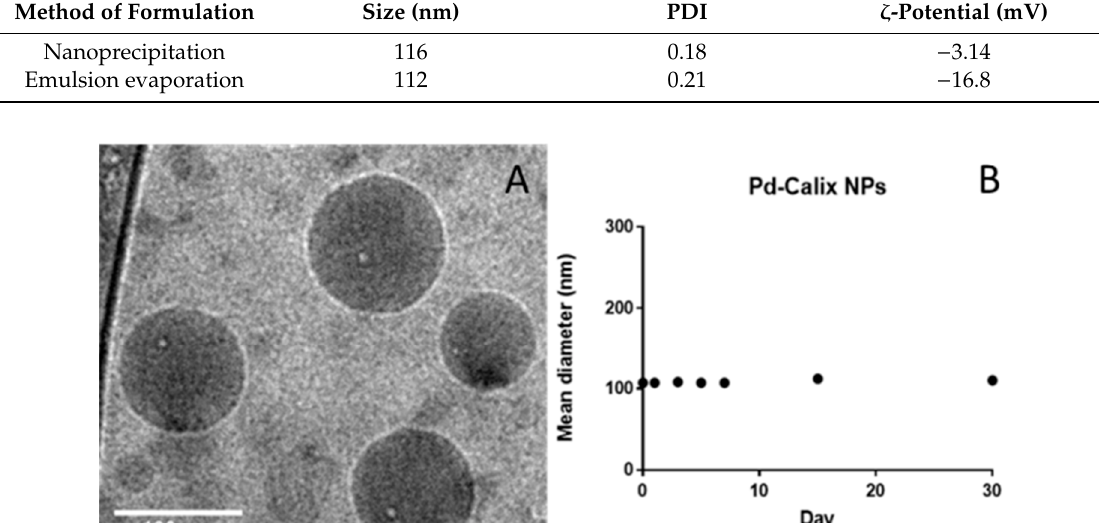
Table 2. Influence of the organoboron derivative on the cross-coupling reaction of N -Boc-4-iodo- L - phenylalanine.